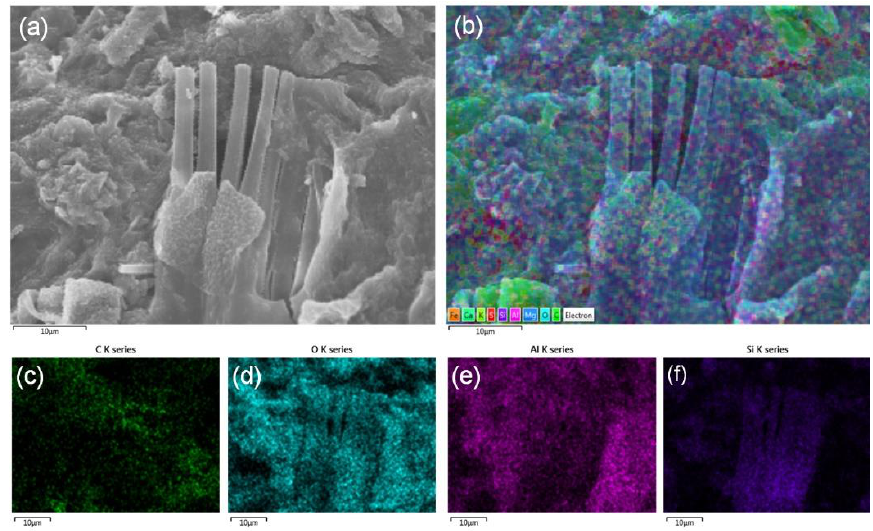
Figure 3. EDS mapping analysis results of the MB samples. ( a ) SEM image (×2000); ( b ) distribution of